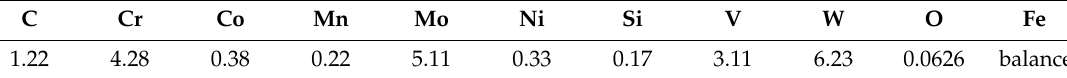
Table 1. Alloying elements and their proportion by weight in M3/2 grade steel.